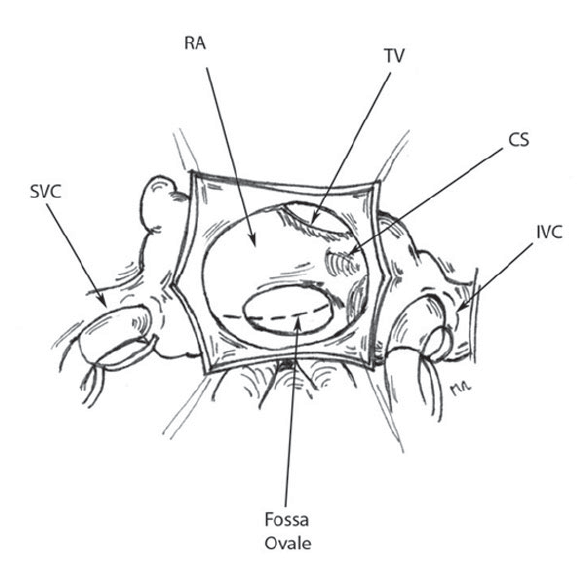
Fig. 1 - General anatomy of the heart during mitral valve surgery.